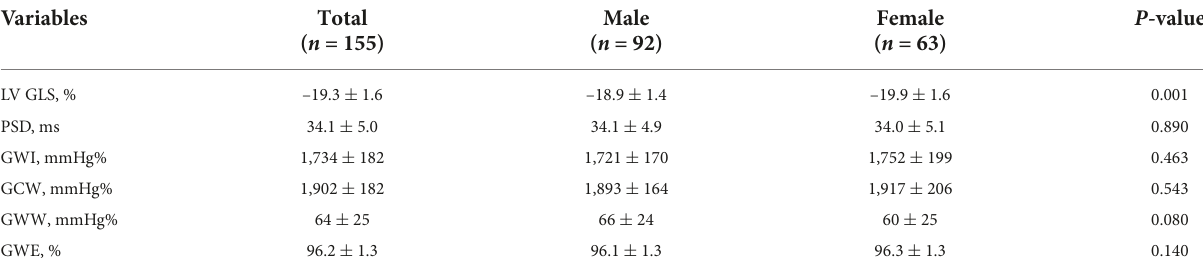
TABLE 3 Advanced echocardiographic characteristics in heathy young people between